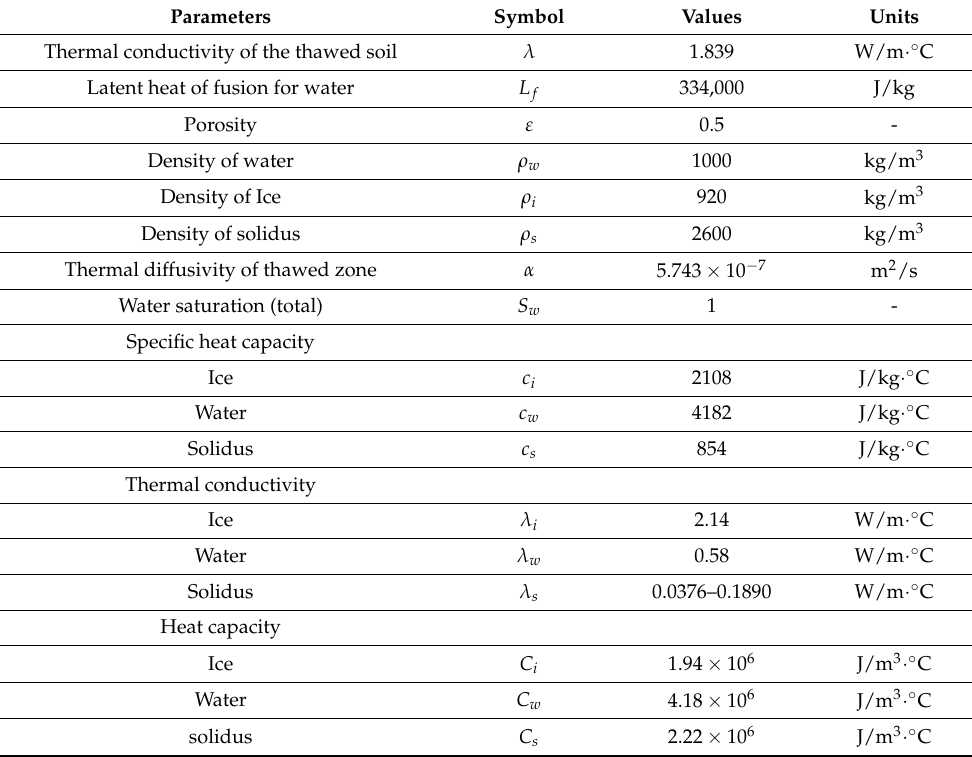
Table 1. Parameters used for comparison with the analytical